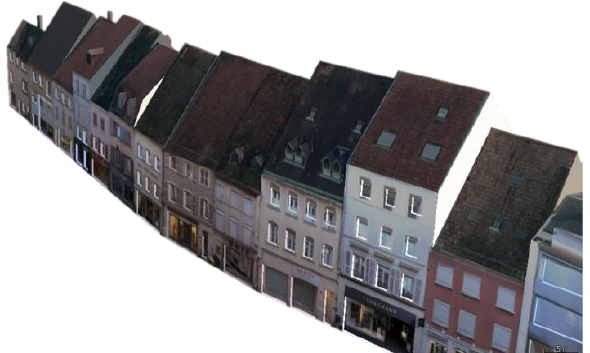
Figure 11: 3D visualisation of textured buildings with intruded openings.